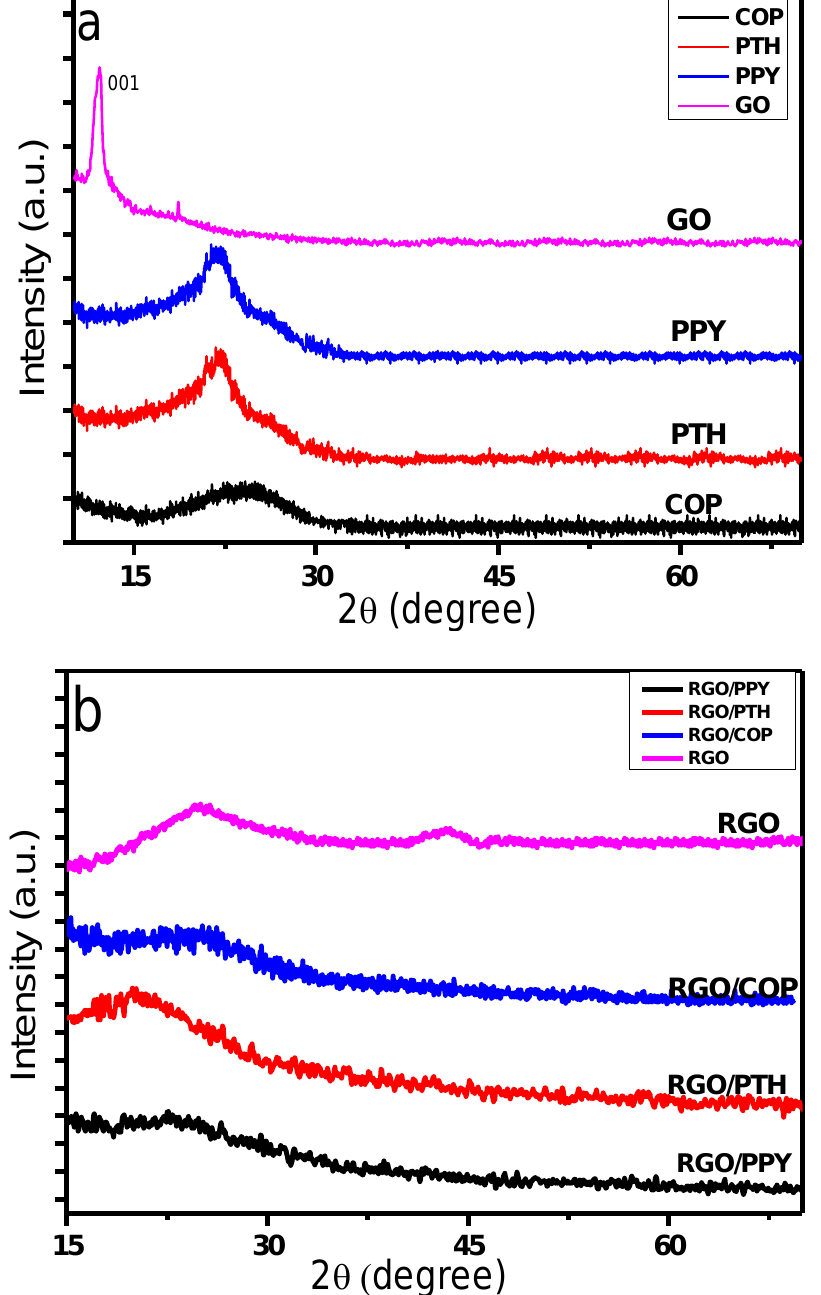
Figure 3. X-ray diffraction (XRD) spectra of ( a ) COP, PPY, PTH, GO; and ( b ) RGO/COP, RGO/PPY, Figure 3. X-ray di ff raction (XRD) spectra of ( a ) COP, PPY, PTH, GO; and ( b ) RGO / COP, RGO / PPY, RGO/PTH, RGO. RGO / PTH,